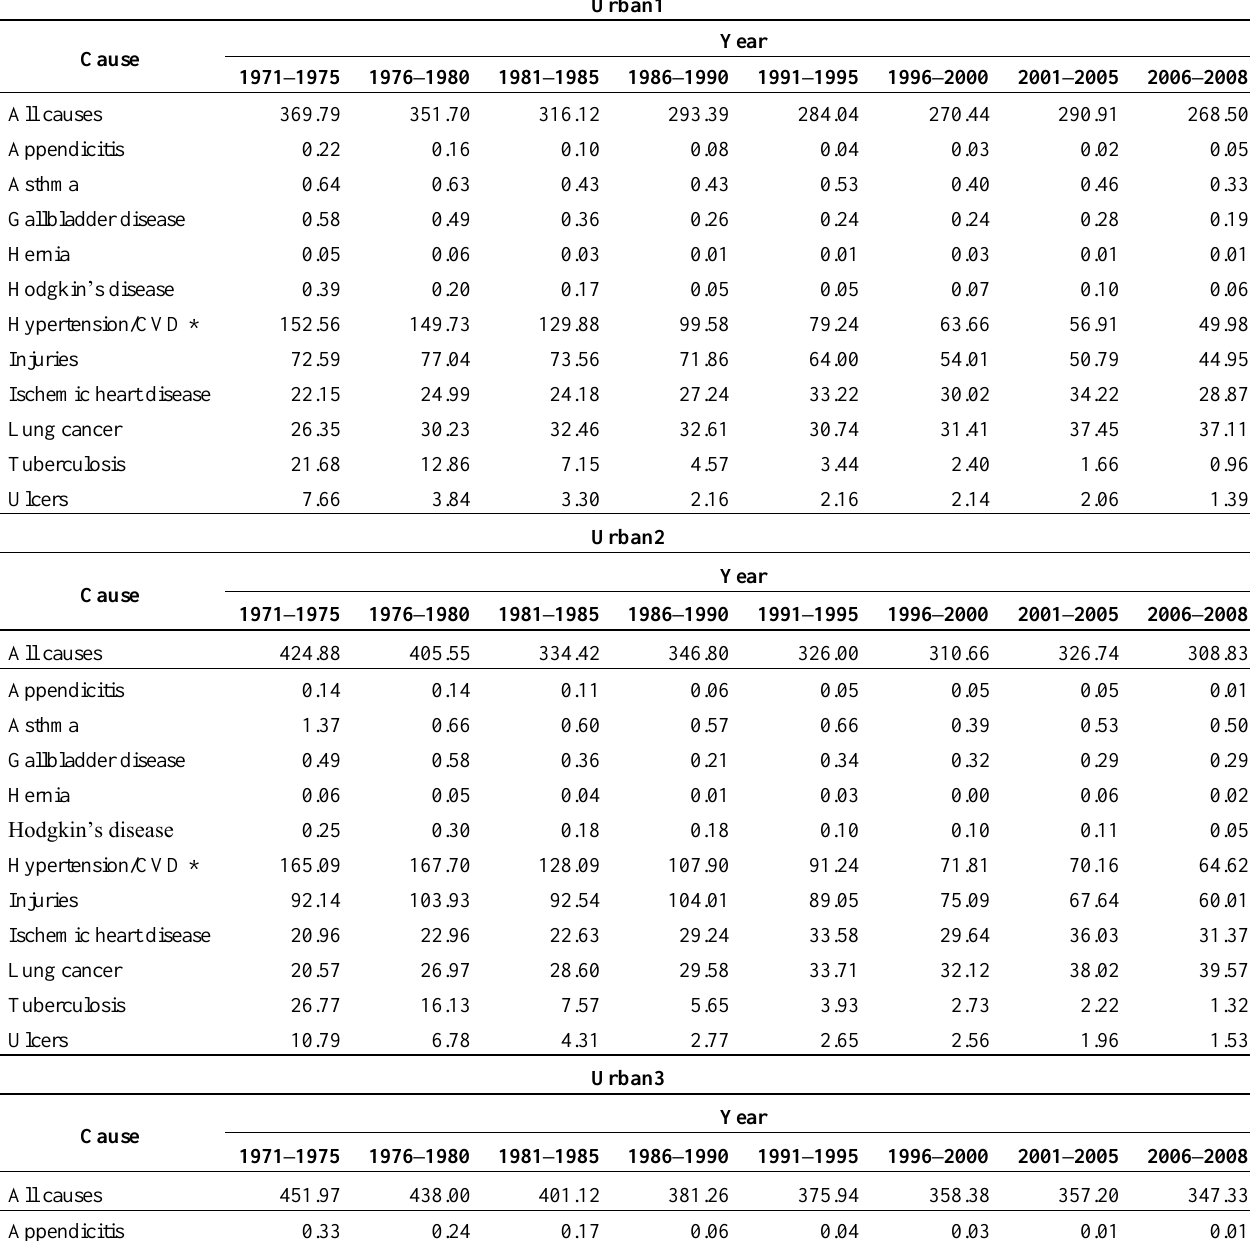
Table 2. Standardized mortality ratio (SMR per 100,000 people), males.